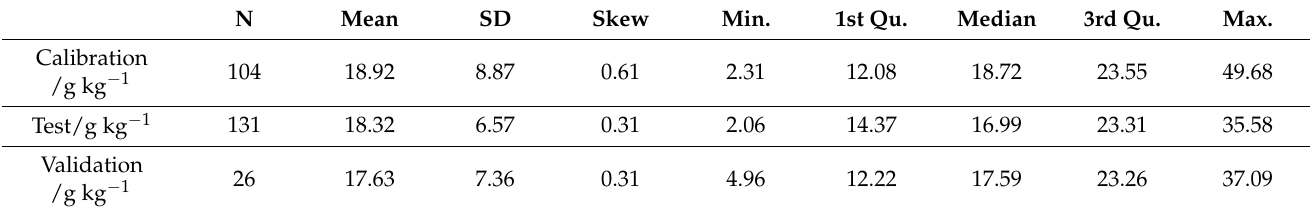
Table 1. Summary statistics of SOM of calibration, test, and validation datasets.